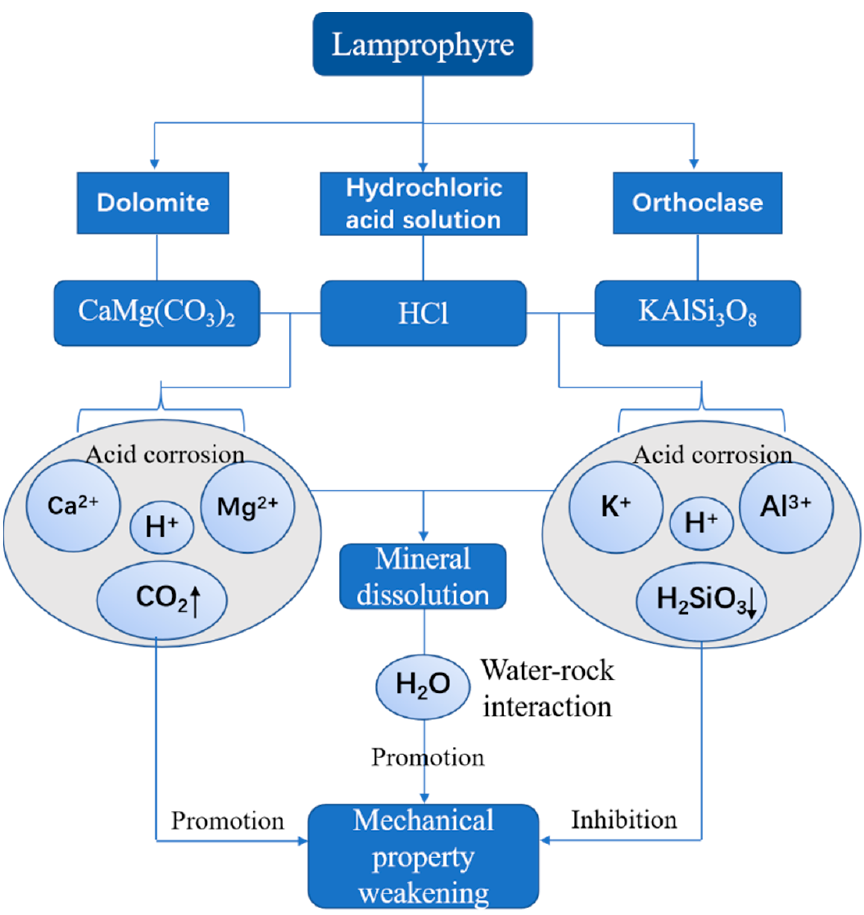
Figure 10. Weakening mechanism and mechanical behaviors of acid corrosion lamprophyre. This paper only concludes that the production of H 2 SiO 3 colloid in the acidification reaction hinders the further development of acid etching. How the influence of H 2 SiO 3 colloid can be reduced on the acidification effect is still worth